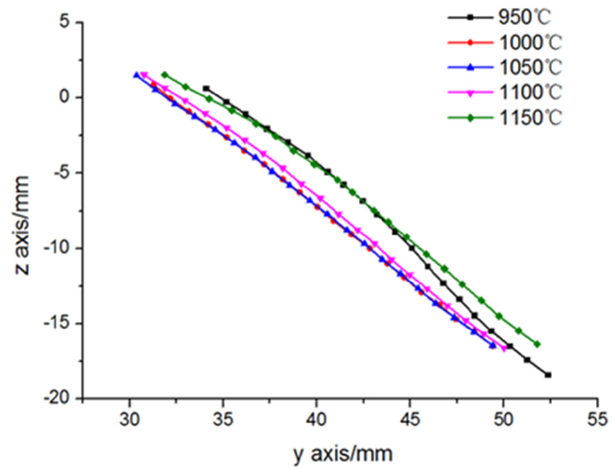
Figure 8. Effect of temperature on straightness.